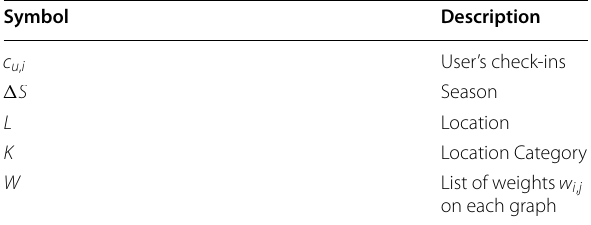
Table 2 Commonly used symbols in the text